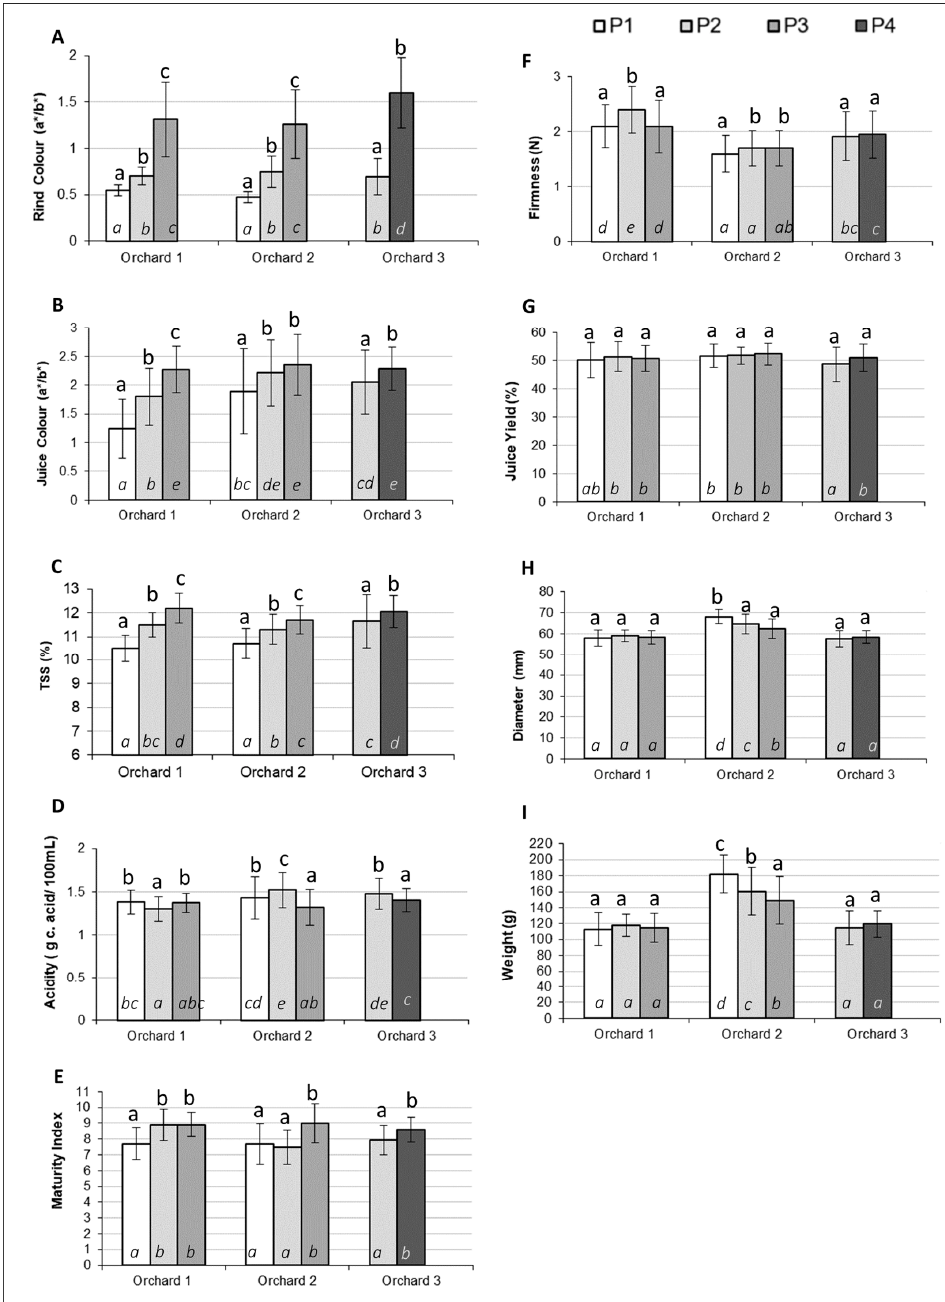
Figure 2. Effect of rind pigmentation intensity (P1—slight, P2—medium, P3—intense, P4—very intense) of ‘Sanguinelli’ on internal properties (( A )—rind colour, ( B )—juice colour, ( C )—TSS, ( D )—titratable acidity, ( E )—maturity index, ( F )—firmness, ( G )—juice yield, ( H )—diameter, ( I )—weight). For each orchard, different letters above the bars indicate significant differences among fruit lots. The italics at the bottom of the bars denote differences among fruit lots when comparing all the fruit lots; i.e., when comparing the lots from the three orchards by Duncan’s multiple range test ( p = 0.05).